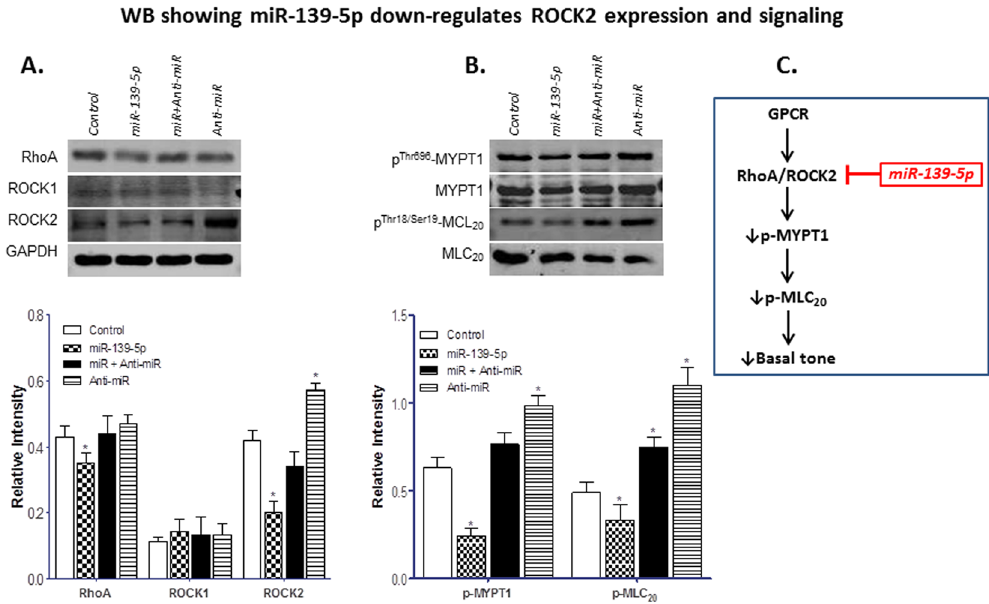
Figure 3. Effect of miRNA-139-5p overexpression on RhoA/ROCK machinery in IAS SMCs. ( A) Western blot data showing that miRNA-139-5p overexpression in the IAS SMCs decreases the expression of RhoA/ ROCK signal transduction machinery proteins which is selectively blocked by the anti-miRNA-139-5p. ( A) (upper portion). Western blots comparing the expression levels of RhoA, ROCK1, and ROCK2 before and after miRNA-139-5p, anti-miRNA-139-5p alone, and following miRNA-139-5p + anti-miRNA-139-5p. The lower portion of the panel provides the corresponding quantitative data showing that miRNA-139-5p causes significant ( * p < 0.05) downregulation of RhoA and ROCK2 without any significant ( p > 0.05) effect on the levels of ROCK1. Conversely, anti-miRNA-139-5p by itself causes significant upregulation of RhoA and ROCK2 ( * p < 0.05). (As indicated, RhoA, ROCK1, and ROCK2 expressions were compared with GAPDH.) ( B) (upper portion).Western blots comparing the expression levels of p-MYPT1and p-MLC 20 , before and after miRNA- 139-5p, anti-miRNA-139-5p alone, and following miRNA-139-5p + anti-miRNA-139-5p. The lower portion of this panel provides the quantitative data showing that miRNA-139-5p significantly ( * p < 0.05) downregulates, while anti-miRNA-139-5p causes significant ( * p < 0.05) upregulation of p-MYPT1 and p-MLC 20 . (As shown, p-MYPT1, and p-MLC 20 expressions were compared with MYPT1 and MLC 20 , respectively.) ( C) Model representing the effect of miRNA-139-5p on RhoA/ROCK2 signaling cascade. The IAS smooth muscle is characterized by upregulated RhoA/ROCK signaling which may be either constitutively active or GPCR- activated. Data suggest that higher levels of miRNA-139-5p in the IAS attenuate ROCK2 expression, which in turn leads to activation of MLCP (via decrease in p-MYPT1), and decrease in p-MLC 20 and basal tone.